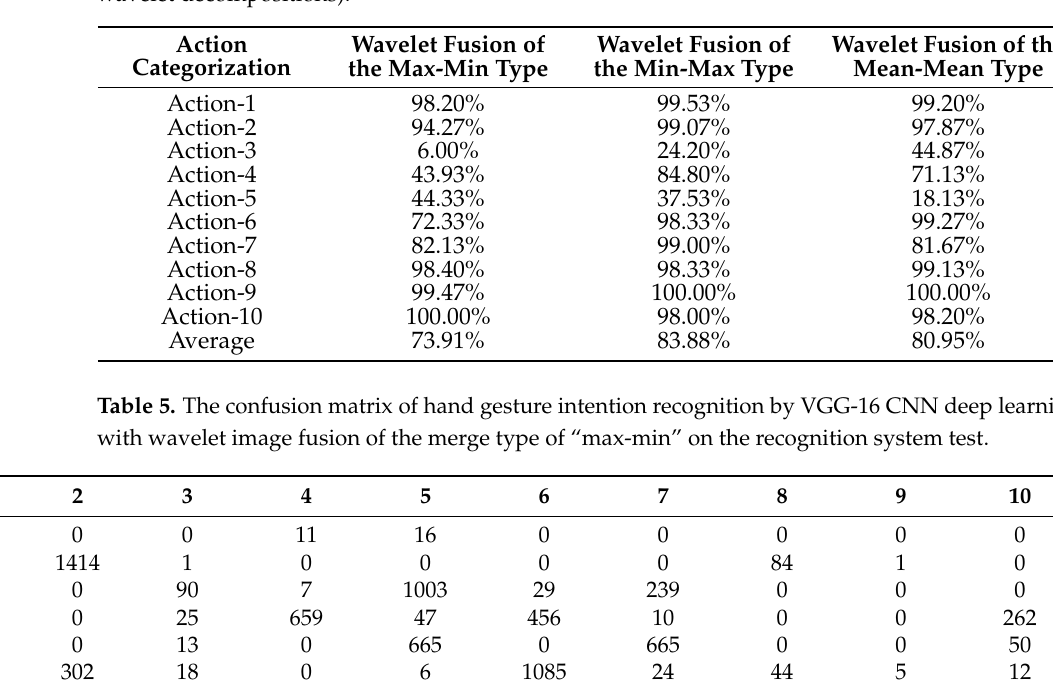
Table 4. Recognition performances of the hand gesture intention recognition using the presented dual-channel VGG-16 CNN with wavelet-based image fusion of two different modalities of data, CCD RGB-IR and depth-grayscale, on the recognition system test (by three different merged types of wavelet decompositions).